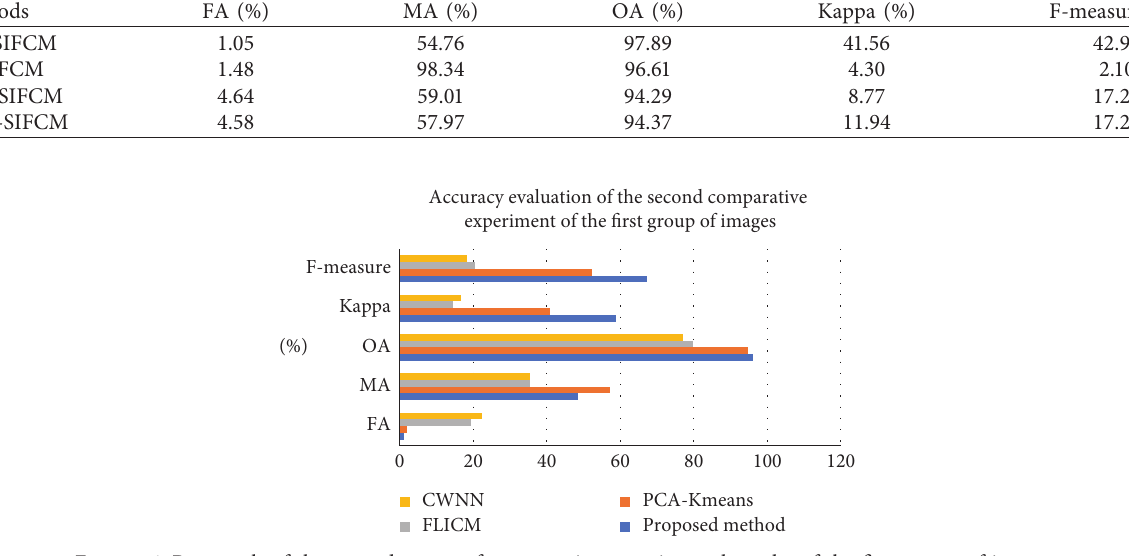
Figure 6: Bar graph of the second group of comparative experimental results of the first group of images.